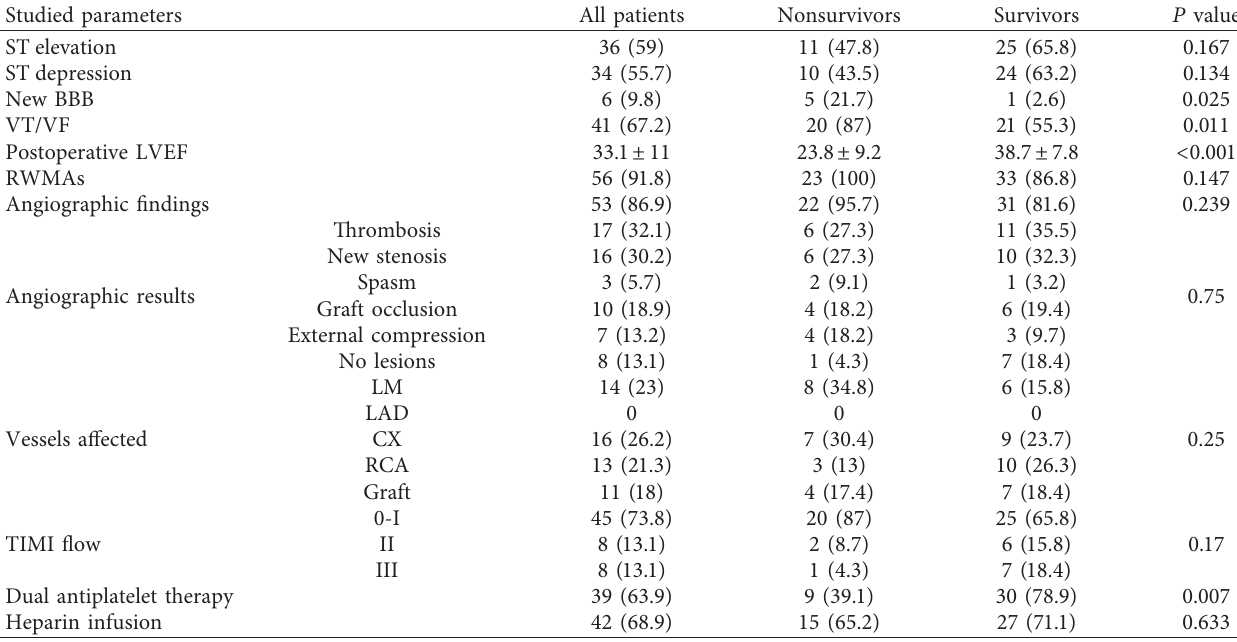
Table 3: ECG, echocardiographic, and angiographic characteristics of studied patients.